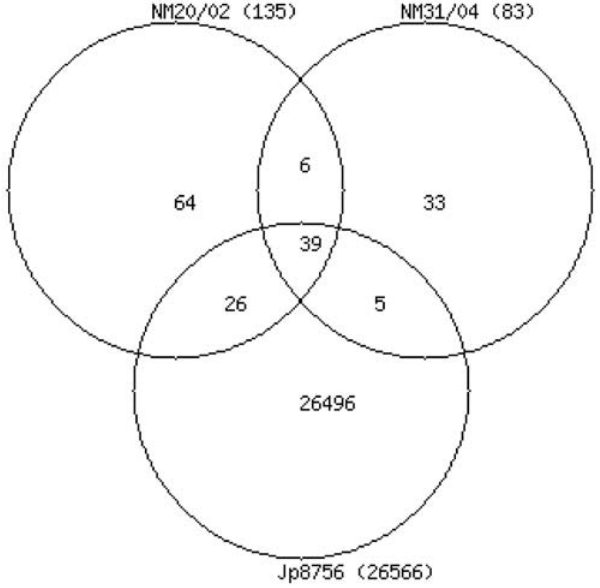
Figure 1. Venn diagram of single nucleotide polymorphisms in M.ulcerans strains.